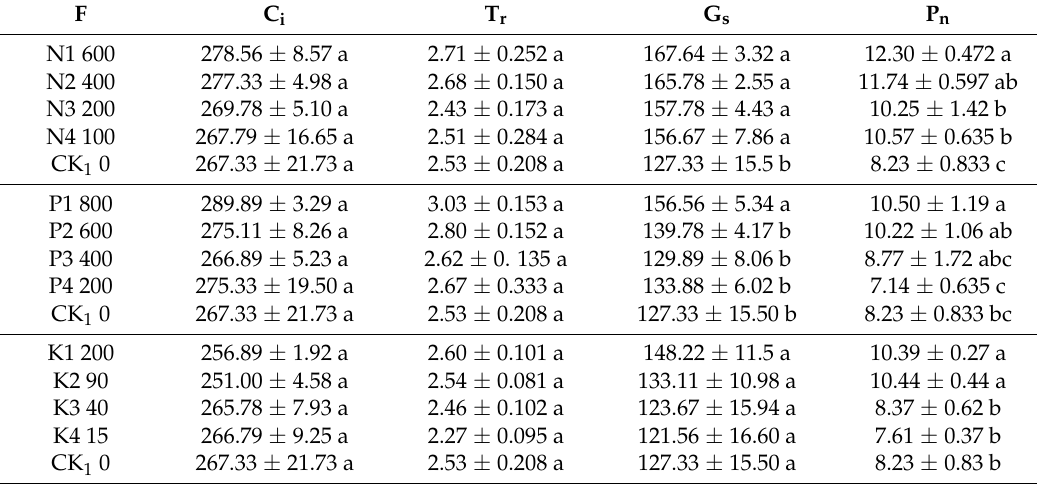
Table 4. Average effects of two years N, P, and K fertilizer (F) in EXP.1 on the photosynthesis